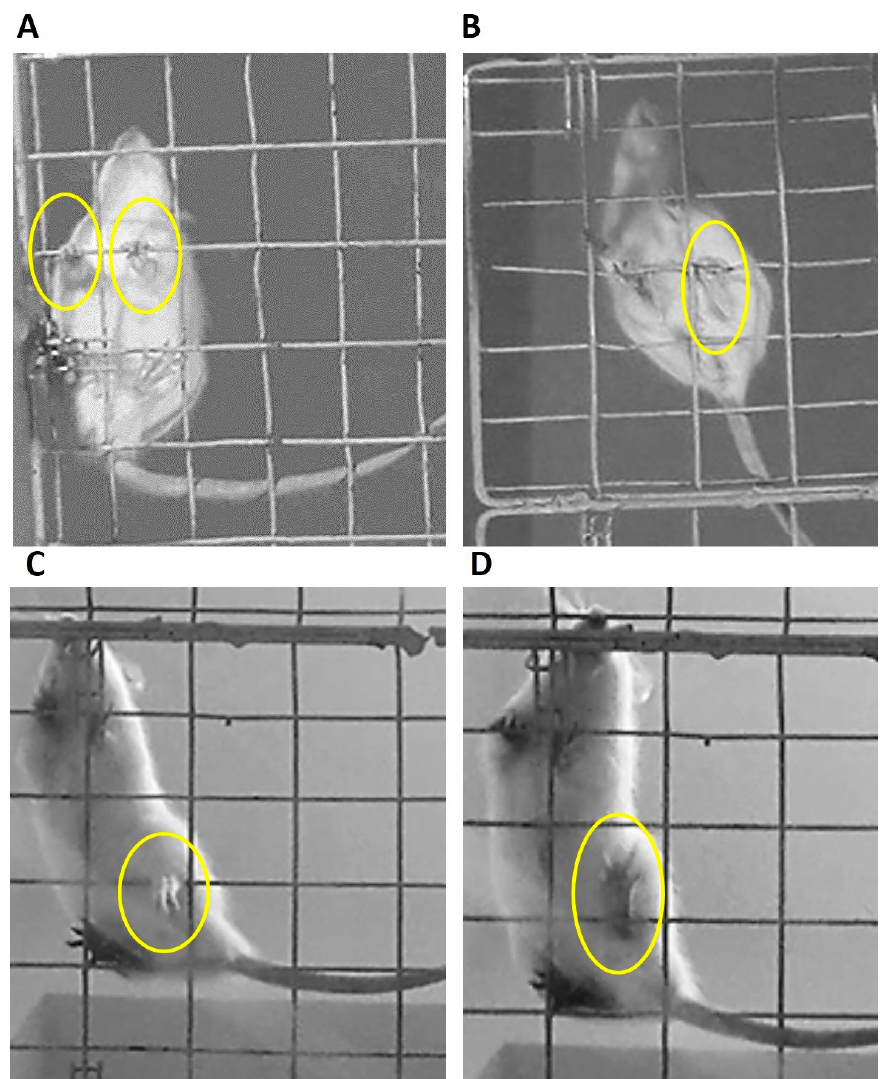
Figure 4. Clamping patterns adopted by the rats during its advance over grid metal. ( A , B ) Corresponding to control groups (non ‐ treated and sham operated rats). ( A ) Correct positioning of the fingers around the grid in the fore limbs. ( B ) Grip of the hind limbs with adequate support and flexion of the fingers. ( C ) Left hind limb of the lesioned rat suspended from the hole of the grid showing an imprecise grip. The partial support is achieved with the external distal edge of the limb. ( D ) Left hind limb of the lesioned rat presents sustained opening of the digits and their hyperextension.